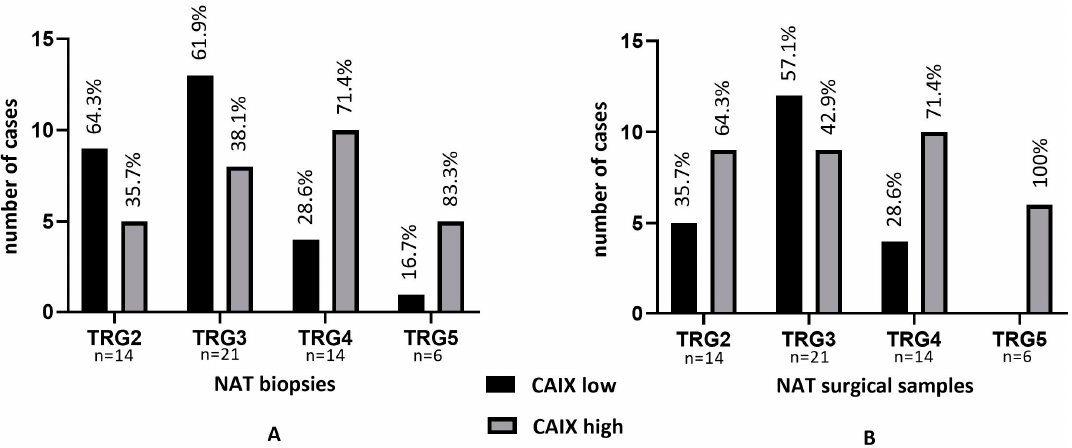
Figure 6. Tumor regression grade (TRG) as defined in post-treatment NAT surgical resection samples and CAIX expression in pre-treatment NAT biopsy ( A ) and post-treatment NAT surgical samples ( B ). Response failure (TRG4–5) is predominantly associated with the CAIXhigh phenotype.